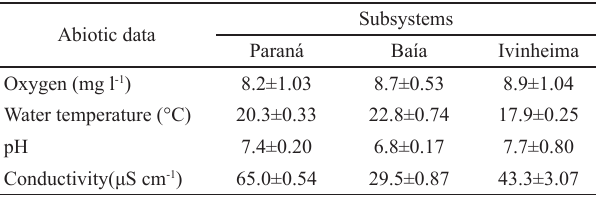
Tab. 1 . Mean values and standard deviations of abiotic pa- rameters from the Paraná, Baía and Ivinheima subsystems in dry